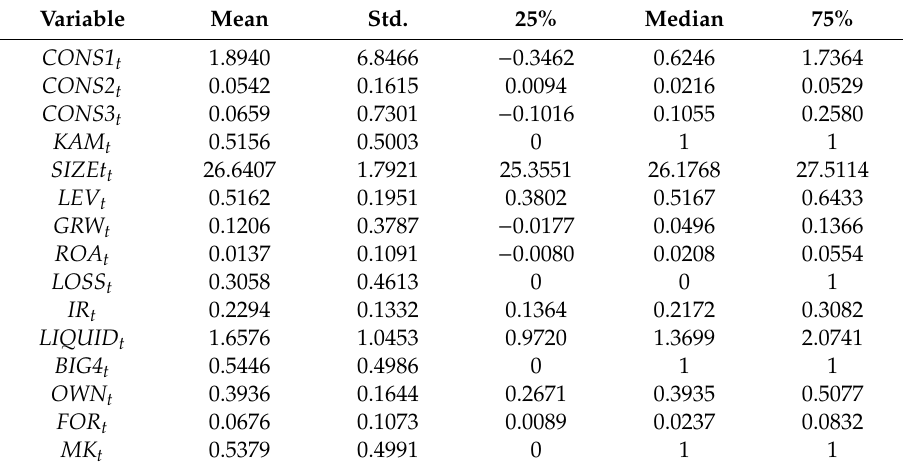
Table 2. Descriptive Statistics ( n =